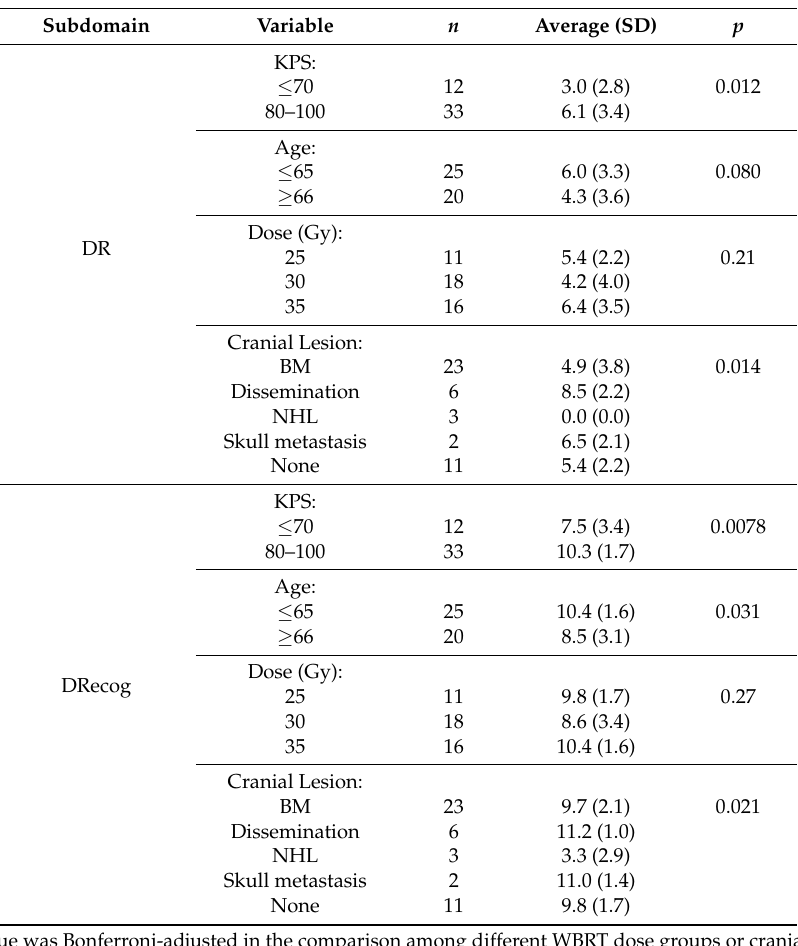
( c ) Figure 1. The Hopkins Verbal Learning Test-Revised (HVLT-R) total recall (TR) ( a ); delayed recall (DR) ( b ); and delayed recognition (DRecog) ( c ) scores of the patients who underwent the examination at the baseline and four months after WBRT ( n = 16). The raw scores are indicated as mean ± SD. * p < 0.01 by Wilcoxon signed rank test. 2.4. HVLT-R Raw Scores of the Patients Who Underwent Three Examinations (Baseline, Four, and Eight Months) (Better-Prognosis Group, n = 29) Figure 2 summarizes the HVLT-R subdomain scores in the patients who also underwent the eight-month examination. There were no significant changes over time in the TR scores ( p = 0.24 by Friedman test), DR scores ( p = 0.14), or DRecog scores ( p = 0.13). ( a )